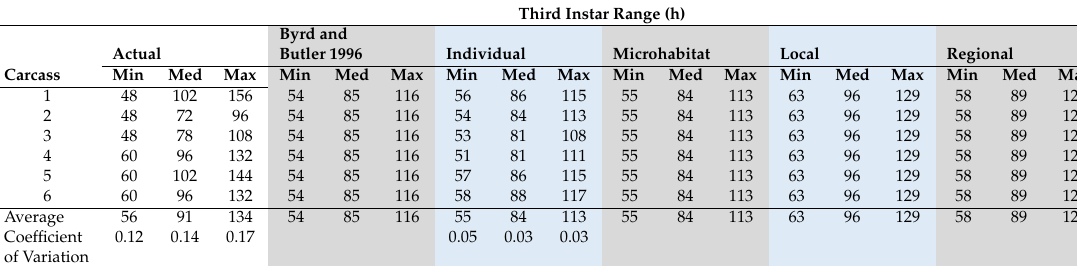
Table 3. Actual and estimated Cochliomyia macellaria post-colonization intervals (PCIs) calculated using third instars and each temperature source, with a minimum developmental threshold of 10 ◦ C. Min, med, and max represent the minimum, median, and maximum ADH value for each PCI. White areas represent actual values, while gray and blue areas represent estimated values [30].